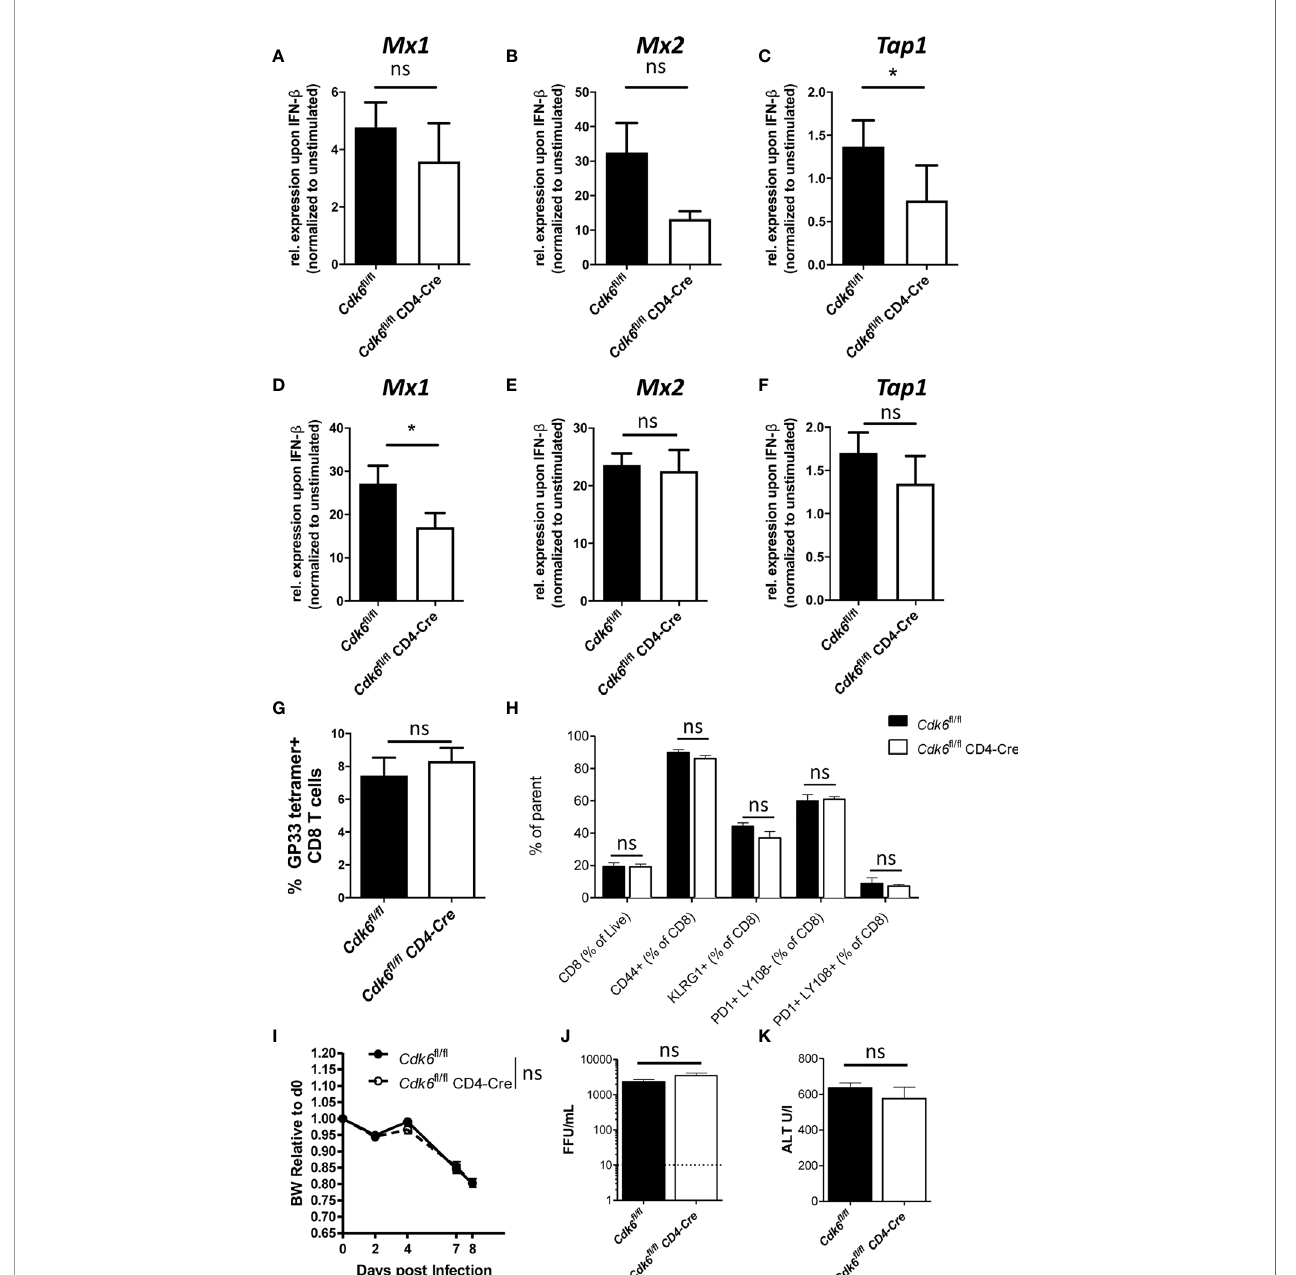
FIGURE 6 | T cell-intrinsic loss of CDK6 partially impairs type I IFN response, but does not affect response to LCMV Clone 13 in vivo . (A – C) Splenic CD8+ T cells were isolated from Cdk6 fl / fl and Cdk6 fl / fl CD4-Cre mice and stimulated with 10U/ml IFN- b for 2h. Cells were lysed and relative expression levels (normalized to Ube2d2 as a house-keeping gene) of Mx1 (A) , Mx2 (B) and Tap1 (C) were analyzed by qPCR. Fold of induction of genes over unstimulated Cdk6 fl / fl controls are shown (n=3). (D – F) Splenic CD8+ T cells were isolated from Cdk6 fl / fl and Cdk6 fl / fl CD4-Cre mice and activated with a CD3/ a CD28 for 48h in the presence of IL-2. Cultured CD8+ T cells were stimulated with 10U/ml IFN- b for 2h. Cells were lysed and relative expression levels (normalized to Ube2d2 as a house-keeping gene) of Mx1 (D) , Mx2 (E) and Tap1 (F) were analyzed by qPCR. Fold of induction of genes over unstimulated Cdk6 fl / fl controls are shown (n=3-4). (G – K) Cdk6 fl / fl and Cdk6 fl / fl CD4-Cre mice were intravenously infected with 2*10 6 focus forming units (FFU) of LCMV Clone 13 and CD8+ T cells were analyzed in the blood 8 days post infection by fl ow cytometry (n=5). (G) Percentage of GP33-tetramer positive CD8+ T cells are shown. (H) Frequency of CD8+ T cells, CD44+, KLRG1+, PD1+Ly108-, PD1+Ly108+ CD8+ T cells were analyzed. (I) Body weight (BW) of LCMV infected Cdk6 fl / fl and Cdk6 fl / fl CD4-Cre mice was monitored and is shown relative to BW on d0. Virus load (J) and ALT levels (K) in the blood of LCMV infected Cdk6 fl / fl and Cdk6 fl / fl CD4-Cre mice were measured on day 8 and 11 post infection, respectively. (A – F) Bar graphs represent mean ± SEM, pooled from 2-3 independent experiments. *p < 0.05, paired t-test. (G – K) Bar graphs or symbols represent mean ± SEM from one experiment. ns, not signi fi